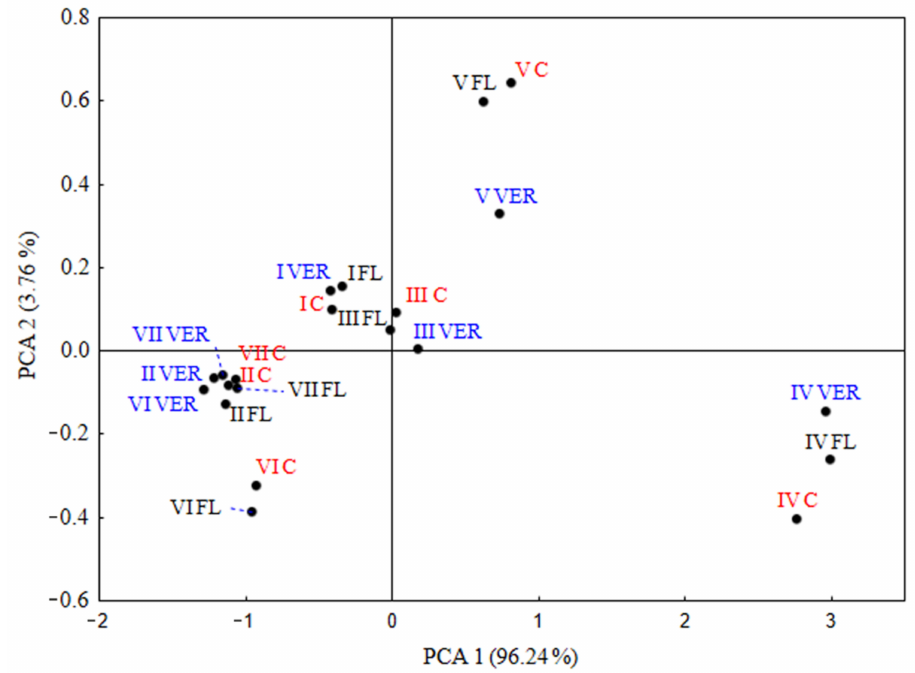
Figure 2. Two dimensional principal component analysis plot for average concentrations of the seven groups of volatile compounds (I: aliphatic esters (up to C8); II: aliphatic esters (C9 and higher); III: aliphatic alcohols; IV: aromatic esters and alcohols; V: ketones; VI: aldehydes; VII: Monoterpenoles and monoterpenes) determined in wine made from control and two defoliation treatments (C = control; FL = removal of six leaves before flowering; VER = removal of six leaves at the end of